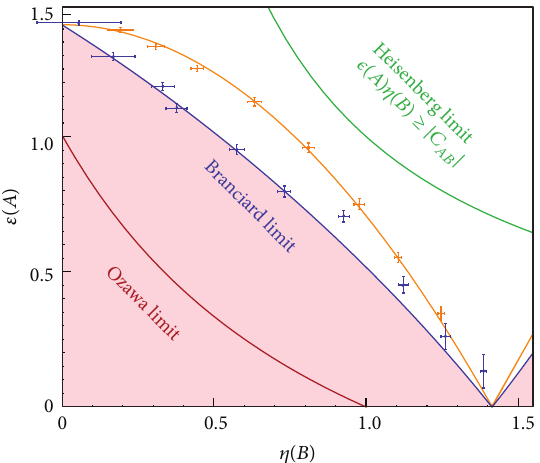
Figure 6: Results of error and disturbance plotted as 𝜖 𝐴 versus 𝜂(𝐵) . Blue curve: the Branciard bound as defined in (6). Blue marker: experimental results using the modified apparatus for 𝜖(𝐴) and 𝜂(𝐵) , as defined in (10). Orange curve error and disturbance as in (9). Green curve: bound imposed by Heisenberg’s original error-disturbance relation 𝜖(𝐴)𝜂(𝐵) ≥ |𝐶 𝐴𝐵 | , which is violated by our experimental results. Red curve: Ozawa’s relation (5), which is indeed satisfied but is not